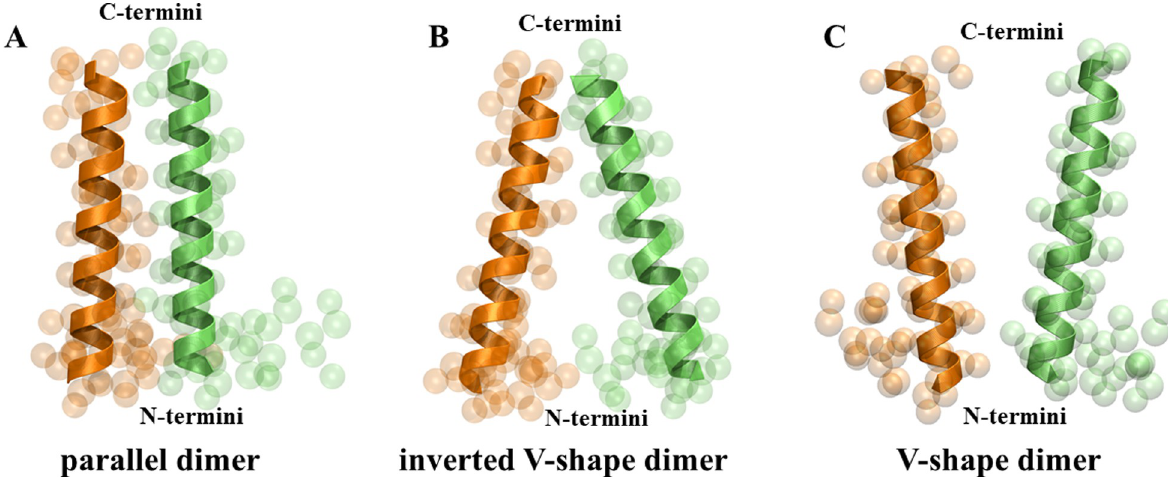
Fig 4. Representative structures (centroids) of three distinctive topologies of the SP-C homodimer ordered by the increasing free energy values: (A) parallel dimer, (B) inverted V-shape dimer, and (C) V-shape dimer. The SP-C monomers involved in the formation of homodimers are colored differently (orange and lime) for